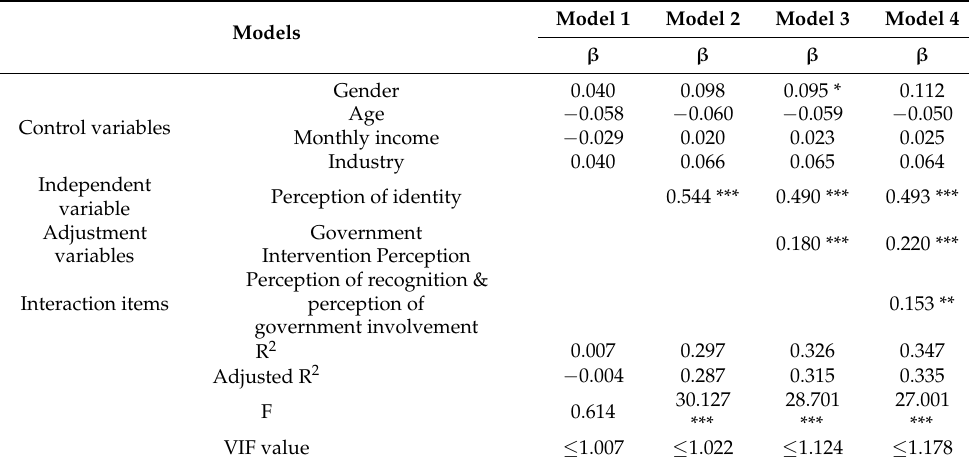
Table 16. Moderating role of perceived government involvement in perception of identity and willingness to